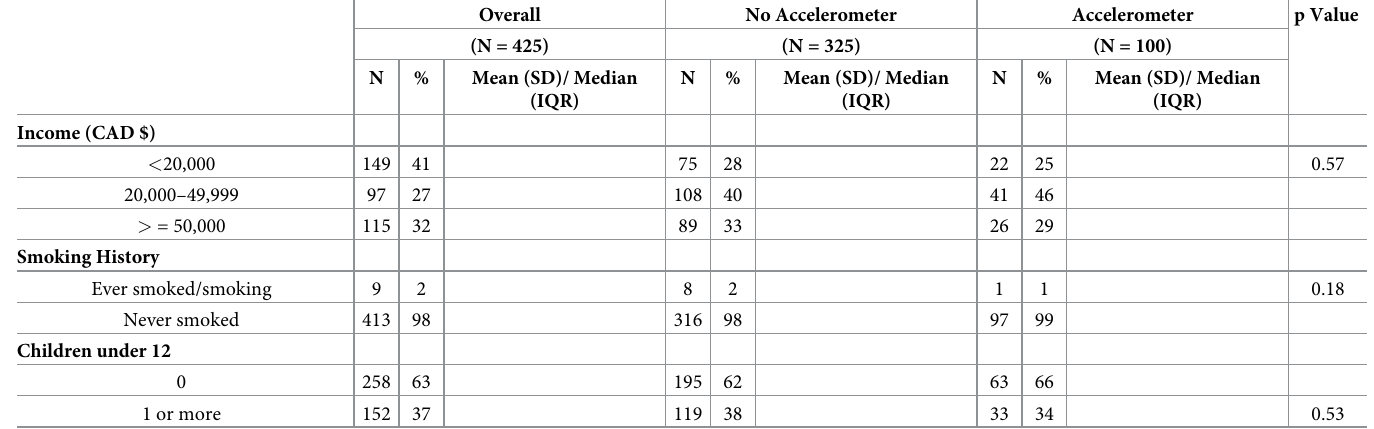
A total of 91 participants (40 women) with complete demographic and anthropometric information and valid accelerometer data were included in the final sample for analysis. Accelerometer measured sedentary time and physical activity levels Participants spent 11.2 hours/day (62.2% of the wake time) being sedentary and 2.2 hours/day (12% of the wake time) in LPA. On average, women accumulated significantly more sedentary time compared to men [694.6 vs 657.4 min/day (95% CI: 671.8, 718.3),]. While not statistically significant, there was a notable absolute difference of 60 min of sedentary time between the youngest (20–59 years) and the oldest ( � 80 years) age group; (688.8 vs 628.1 min/day respec- tively). Similarly, married participants accumulated 58.7 min/day more in sedentary time than the ‘other’ category. LPA was significantly higher in the younger age group (20–59 vs � 60) [186.1 vs 120.3 min/day (95% CI: 136.9, 206.4)], those with a BMI in the over-weight (25–29.9 kg/m 2 ) vs healthy range (18.5–24.9 kg/m 2 ), [142.9 vs 100.3 min/day (95% CI: 72.9, 130.8], mar- ried, [136 vs 81.7 min/day (95% CI: 121.7, 151.9)], and with annual income between $20,000– $49,999 vs < $20,000 [139.0 vs 96.5 min/day (95% CI: 117.9, 163.9)]. MVPA was significantly higher during the summer season [5.4 (95% CI: 2.4, 12.2)] vs winter [0.8 min/day (95%CI: 0.3, 2.3)] during weekdays [2.2 (95% CI: 1.2, 4.2)] vs weekend [0.6 min/day (95% CI: 0.3, 1.2)] and among those who were currently employed [10.3 (95% CI: 0.7, 3.1) vs not working [1.5 (95% CI: 5.3, 20.0)]. Those with greater than high school education accumulated 6.2 min/day more in MVPA than those with less than high school education but this difference was not statisti- cally significant. LPA, MVPA and number of steps were significantly higher on weekdays com- pared to weekends. Sedentary time did not differ significantly between weekend and weekdays (Table 2). Pearson’s correlation showed a positive association between LPA and MVPA (r = 0.42, p < .001) indicating that as LPA increases so does MVPA. A negative correlation was observed between age and LPA (r = − 0.37, p = < 0.001). Accumulation of sedentary time and PA differed by time of day (Fig 1). When stratified by sex, an association was observed in women for sedentary time; women accumulated signifi- cantly more sedentary time in the afternoon than men [265.9 min (95% CI: 252.2, 280.4) vs 224.8 (95% CI: 212.3, 238)], (S1 Table). Nineteen out of 91 participants (22%) met the PA guidelines of acquiring at least 150 min- utes of